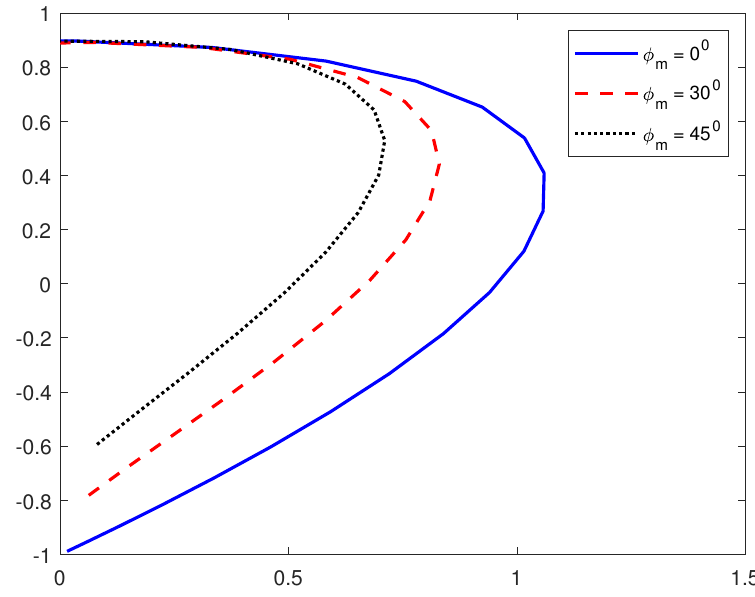
Figure 11. The stability region for single-area LFC system with Φ m = 0 ◦ , Φ m = 30 ◦ and Φ m = 45 ◦ .